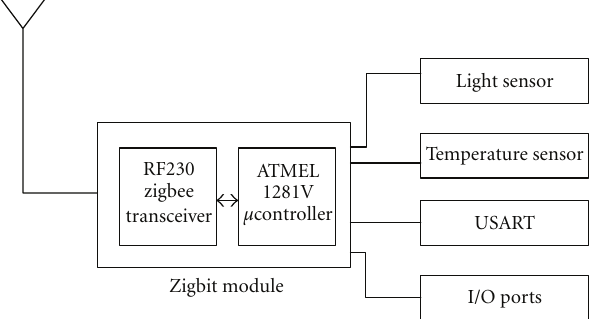
Figure 4: Meshnetics meshbean module block